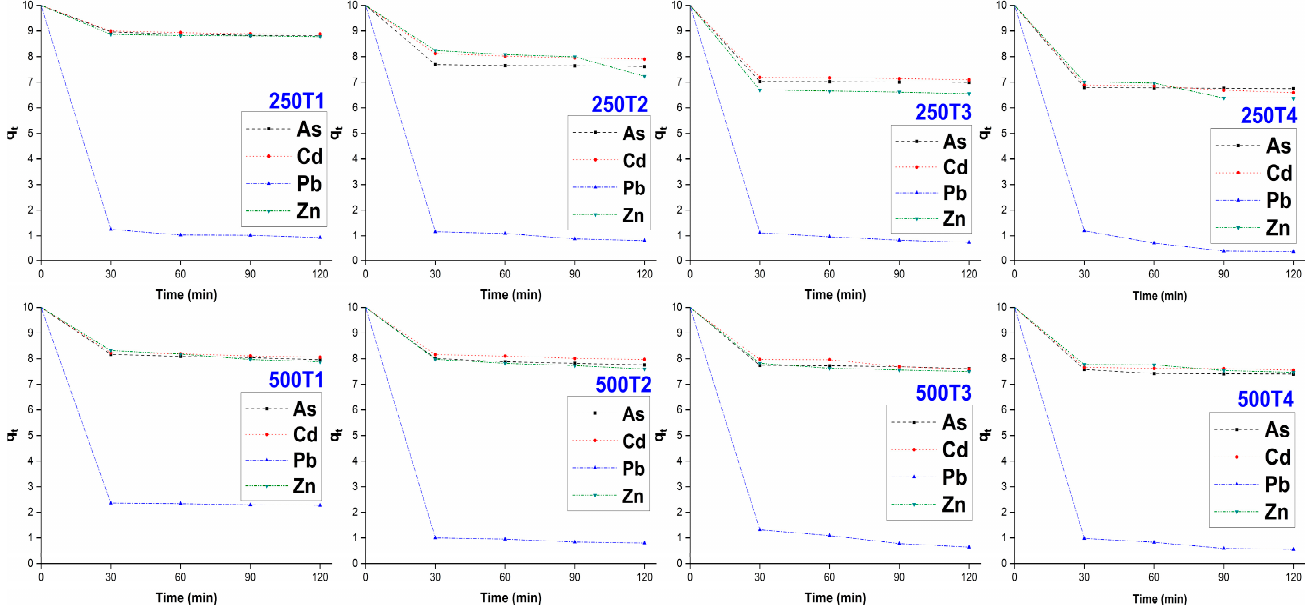
Figure 5. Variation of heavy metal biosorption over time in the fractions of 250 and 500 µm.